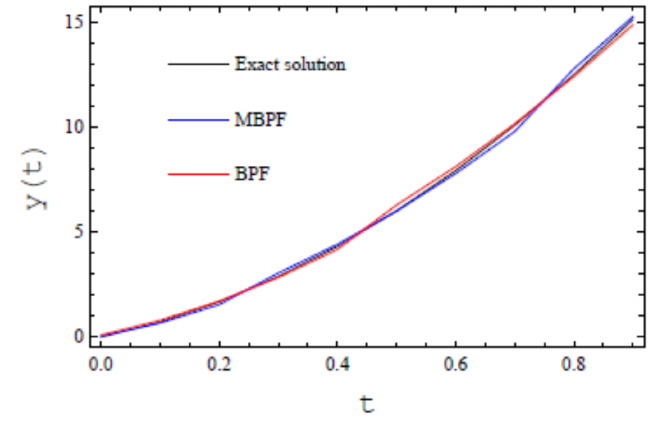
Figure 3. The comparison between the exact values and the approximation of both BPFs and IBPFs solutions.